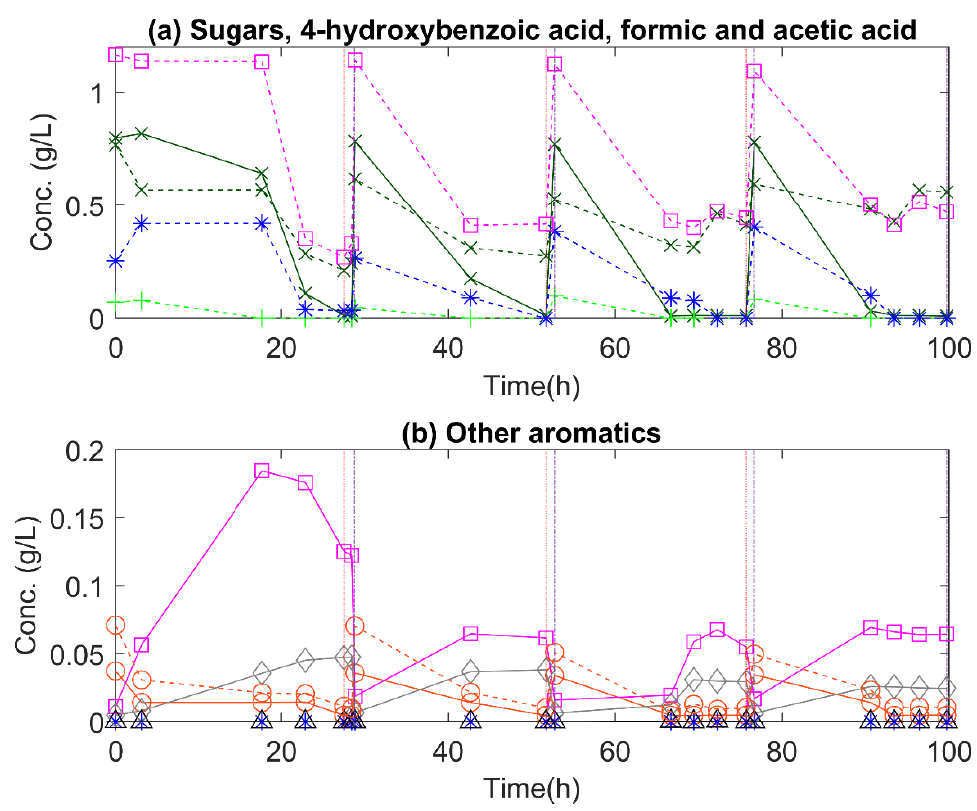
Figure 3. Substrate consumption by R. kratochvilovae as measured by HPLC, with ( a ) presenting the concentration of (-x-) 4-hydroxybenzoic acid, (- -+- -) glucose, (- -*- -) xylose, (- -x- -) formic acid, (-- □ --) acetic acid, and ( b ) presenting the concentration of (- ○ -) 5-HMF,(-+-) furfural, (-*-) 3,4-dihydroxybenzaldehyde, (- □ -) vanillic acid, (- ♢ -) syringic acid, (- △ -) vanillin, and (- - ○ - -) syringaldehyde. Vertical dotted lines (···) indicate the start of the harvest phase, while vertical dash-dotted lines (-·-·) indicate the start of the second, third, and fourth cycles. The concentrations presented are the result of one measurement.